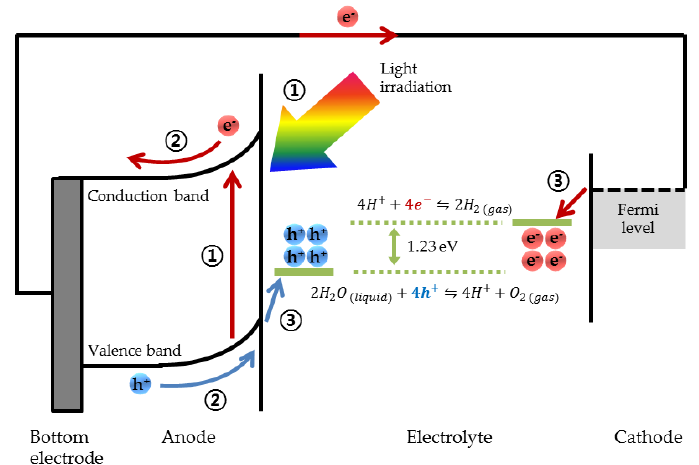
Figure 1. Schematic representation of the photoelectrochemical (PEC) water splitting process in a common PEC water splitting system consisting of a photoanode and a metal counterpart.